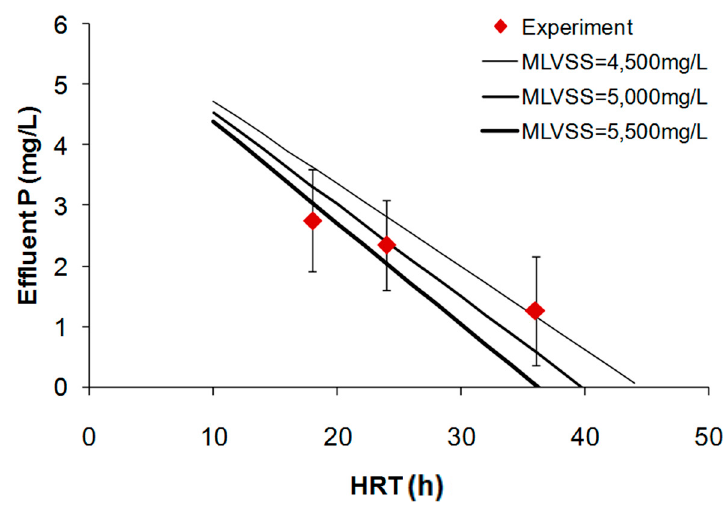
Figure 4. Effect of HRTs on effluent phosphate concentration.